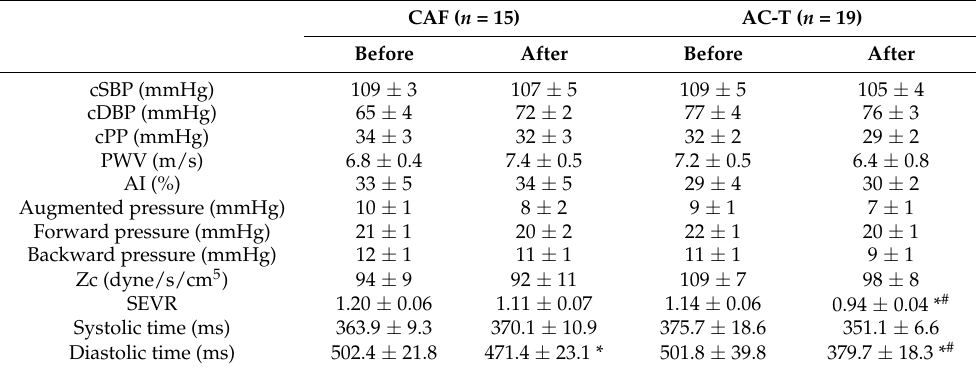
Table 2. Characteristics of cardiovascular hemodynamic parameters in participants. CAF ( n =